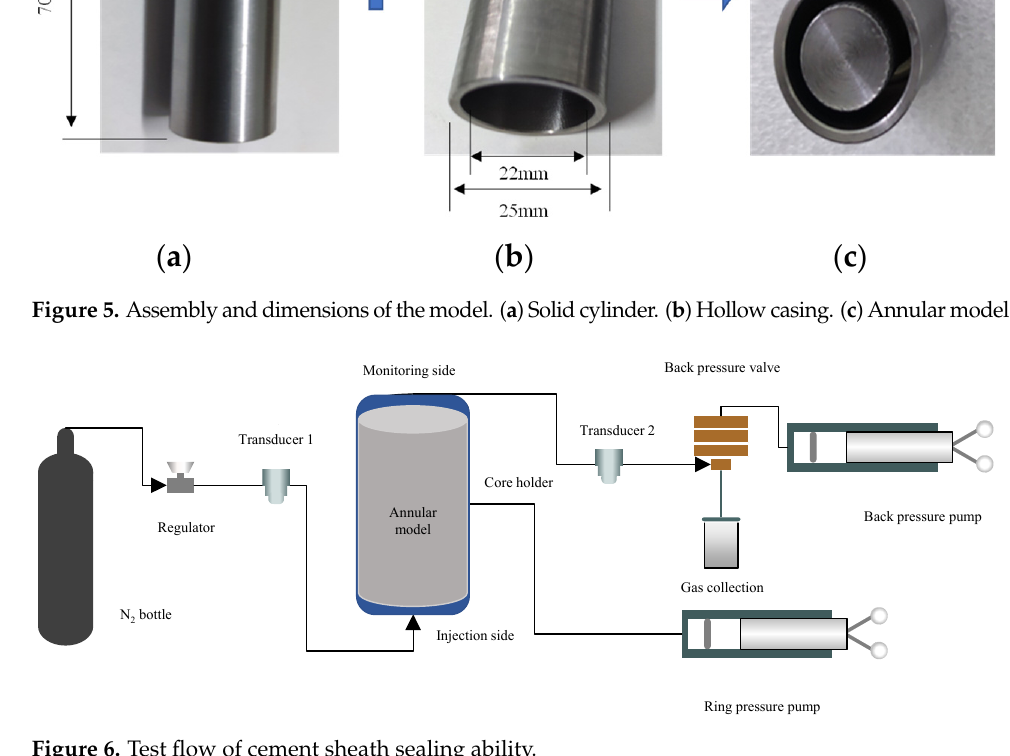
Figure 6. Test flow of cement sheath sealing ability .